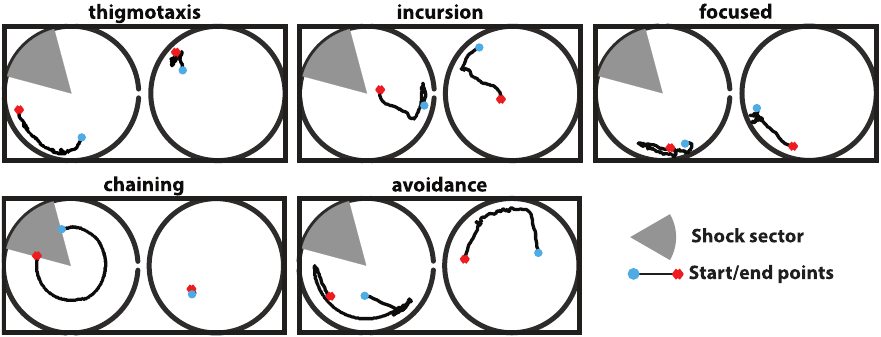
Figure 2. The five stereotypical behaviours, manually identified. Left plots: room coordinates; right plots: arena coordinates.